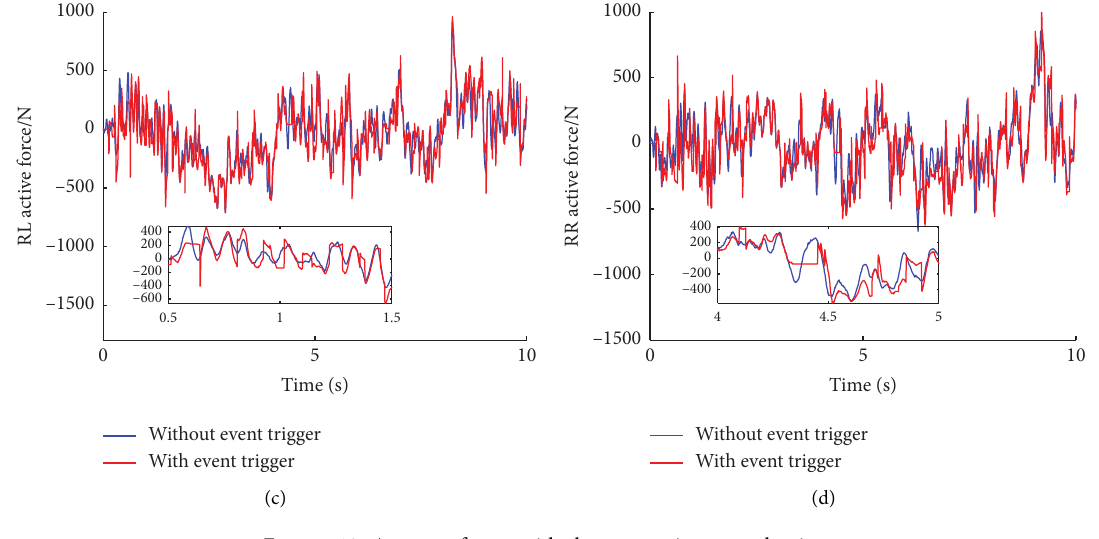
Figure 12: Actuator forces with the event trigger mechanism. Table 3: Comparison of root mean square